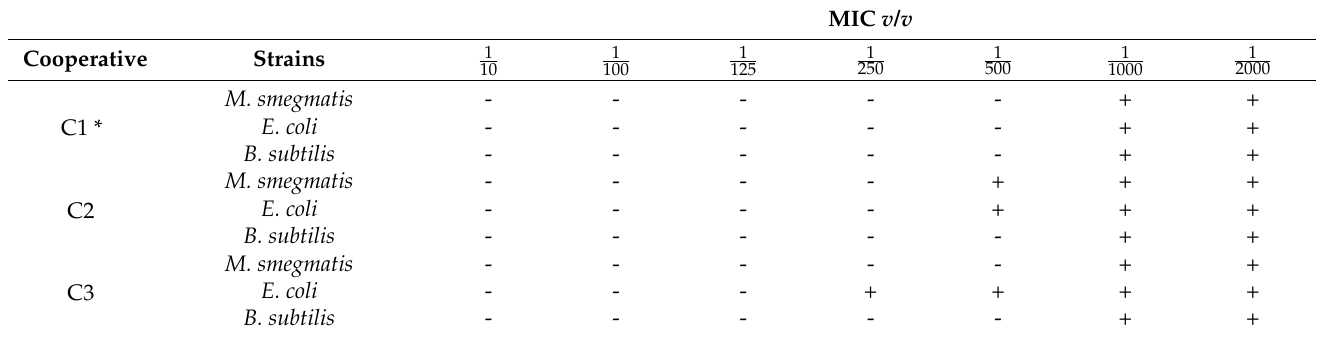
Table 3. Minimum inhibition concentration of S. rosmarinus essential oils